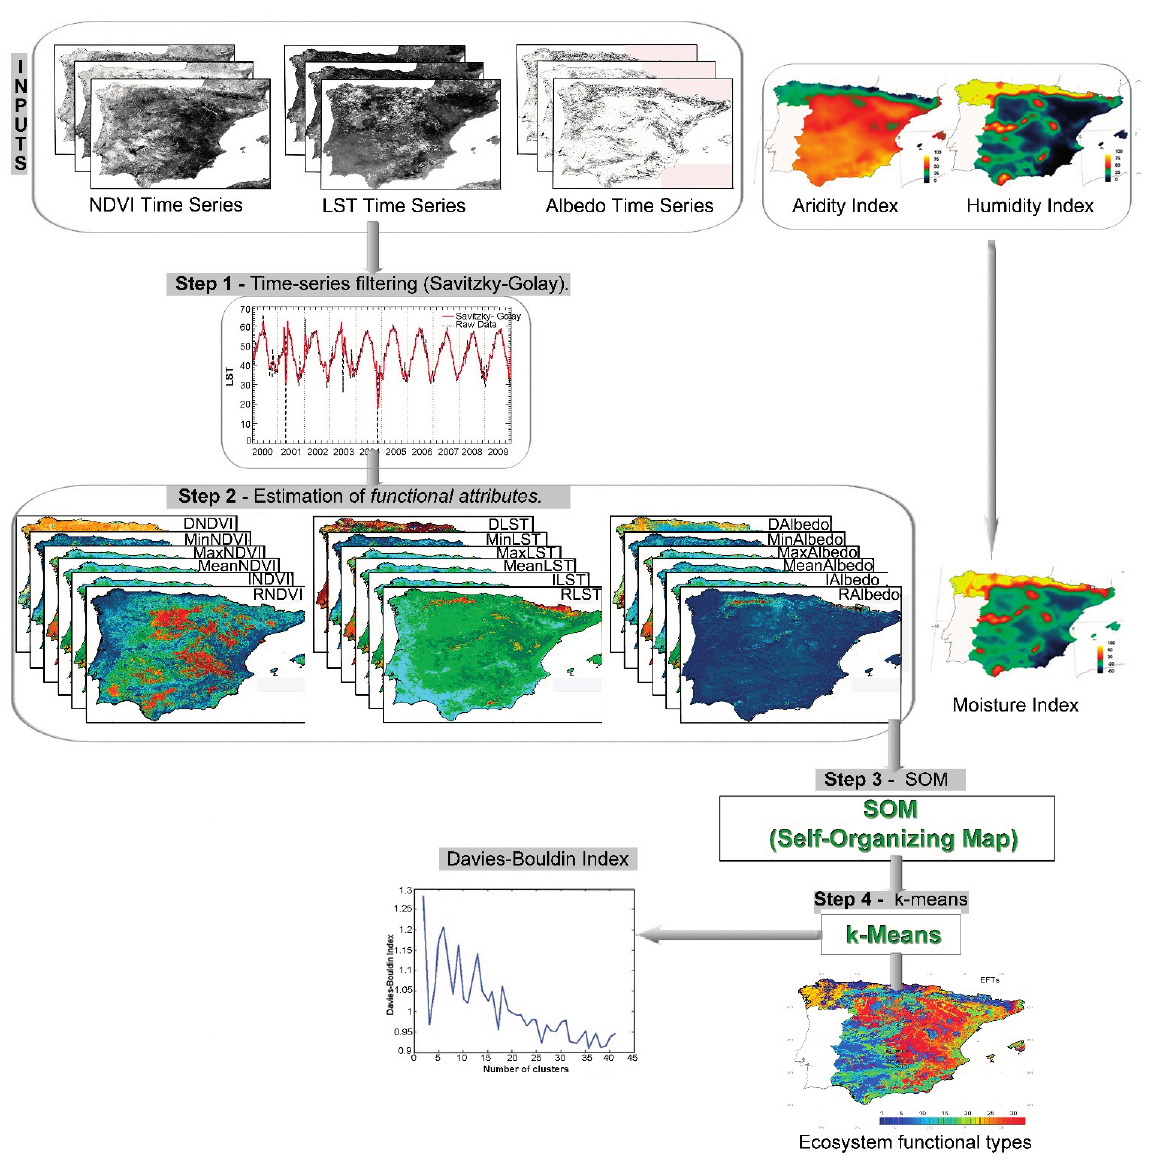
Figure 2. Flowchart of the methodology used to derive the ecosystem functional types